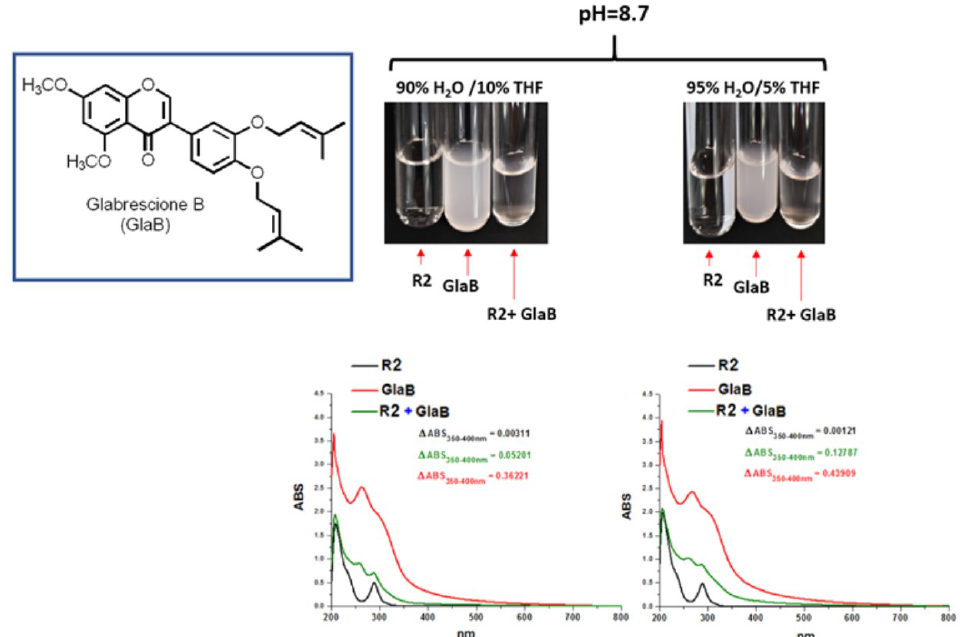
Figure 10. The ability of lyophilic colloids based on resorc[4]arene R2 to encapsulate GlaB by using a THF/(buffer-pH 8.7 ) mixture at different δ H values.